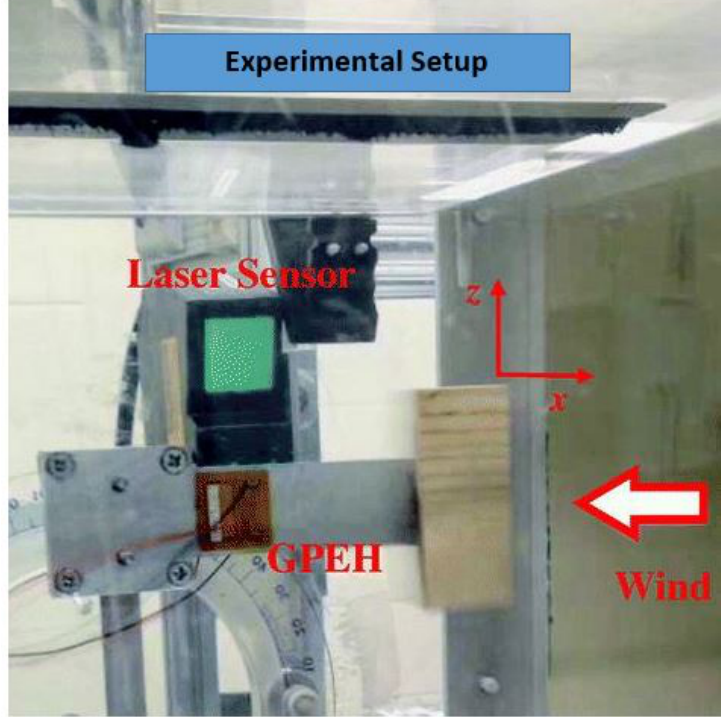
Figure 13. Galloping-based PEH (GPEH) in a test section of a subsonic wind tunnel [167].